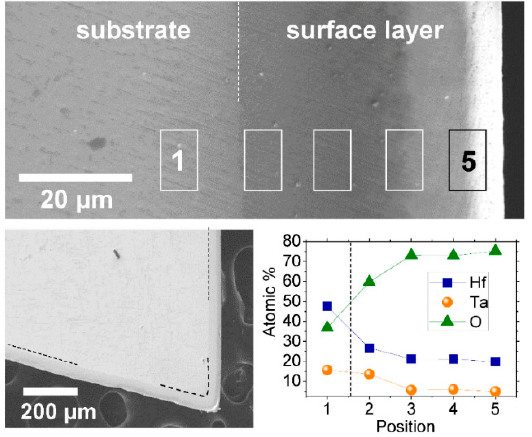
Figure 2. SEM and EDS results on the reaction layer of the HT-1 sample after oxidation. The dashed lines indicate the interface between the substrate and surface layer formed during oxidation.